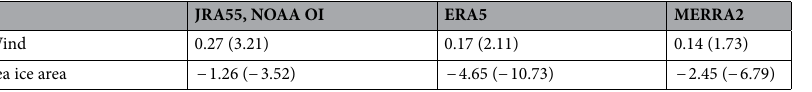
Table 4. Linear trends of surface wind (ms -1 per decade) and ice area (× 10 4 km 2 per decade) averaged over the Sea of Okhotsk for winter during the study period of 40 years. Values in parentheses indicate the relative trends (% per decade).